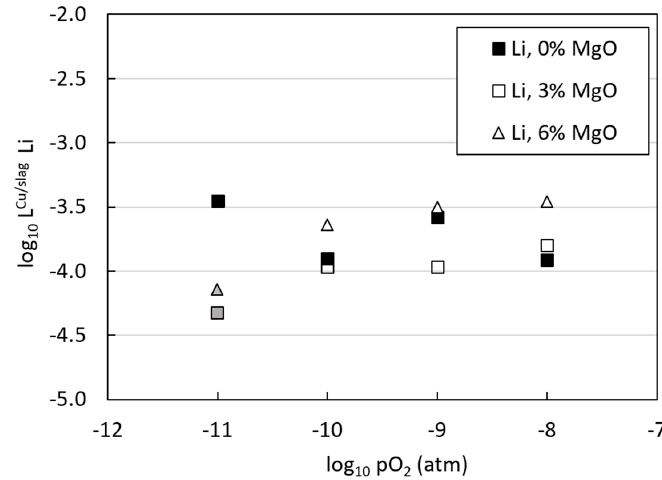
Figure 5. The distribution coefficient of lithium between copper alloy and molten slag. The values for MgO-containing slags in p(O 2 ) = 10 − 11 atm (grey triangle and square) have been calculated based on the detection limits in the copper alloy, as the concentrations were below detection limits of LA-ICP-MS in all analysis points.